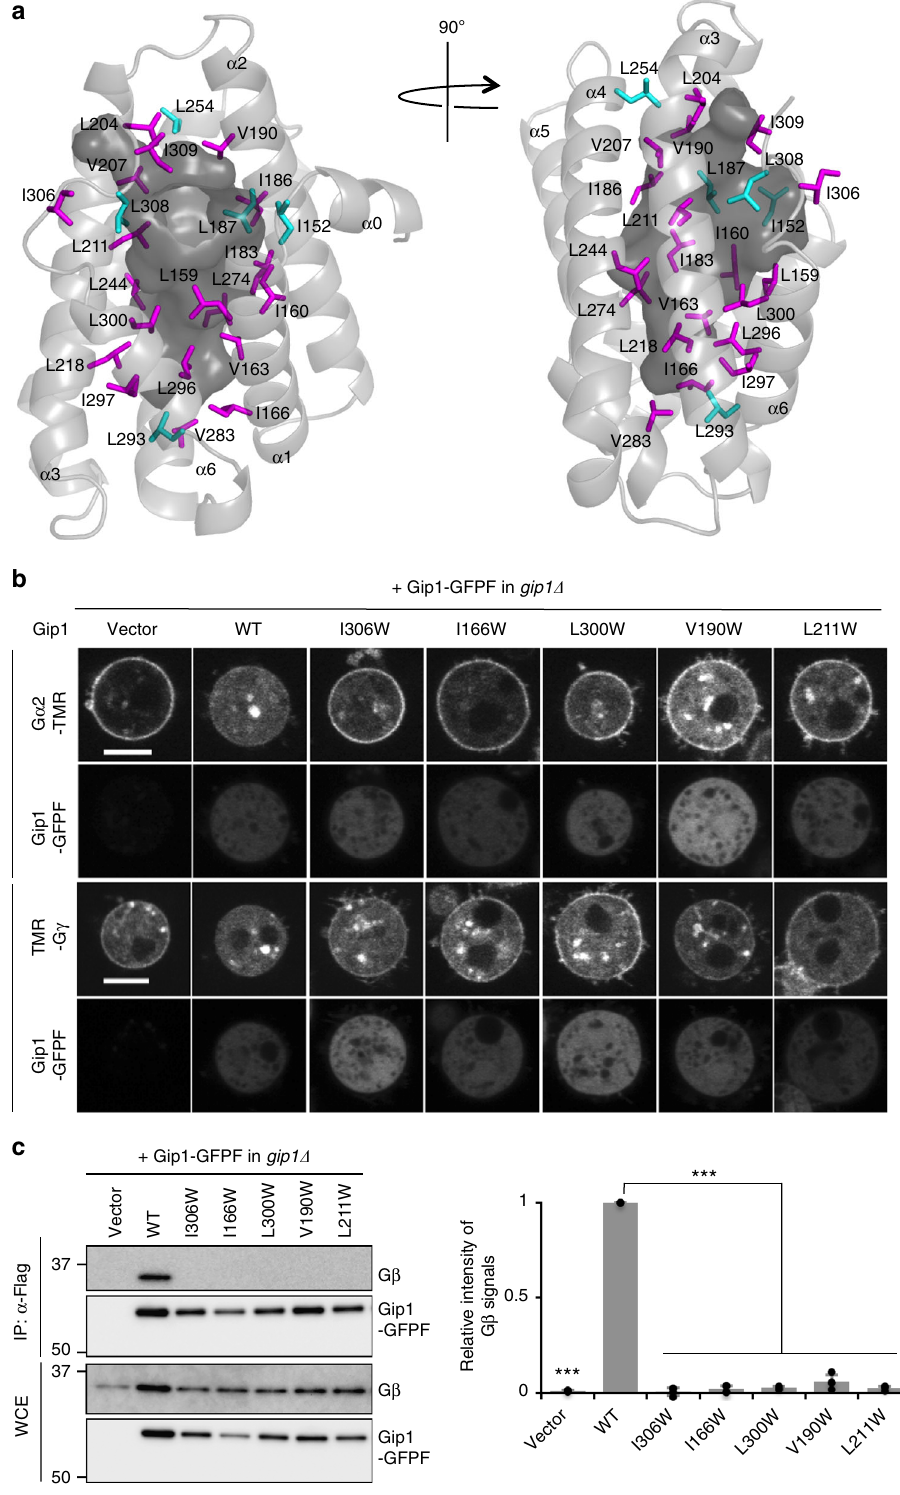
Fig. 5 Tryptophan mutagenesis to induce steric blockade in the cavity. a Representation of tryptophan-mutated residues. Mutated residues are shown as stick models. Magenta and cyan colours show the residues that lead to cytosolic G α reduced and the residues with no effects, respectively. The surface of the cavity is coloured dark grey. b Subcellular localization of G α 2 and G γ labelled with TMR and Gip1-GFPF in a living cell in the presence of LatA. Representative images of the top 25% of severely impaired mutants are shown. Scale bar, 5 μ m. c Co-immunoprecipitation of Gip1 with G βγ . The same mutants shown in b were analysed. The data were normalized relative to the band intensities of wild-type Gip1 and are presented as the mean ± SD of at least three independent experiments ( n = 5 (Vector, WT), 4 (I306W, I166W, V190W), and 3 (L300W, L211W), *** P < 0.001 versus wild-type, two-tailed unpaired Student ’ s t